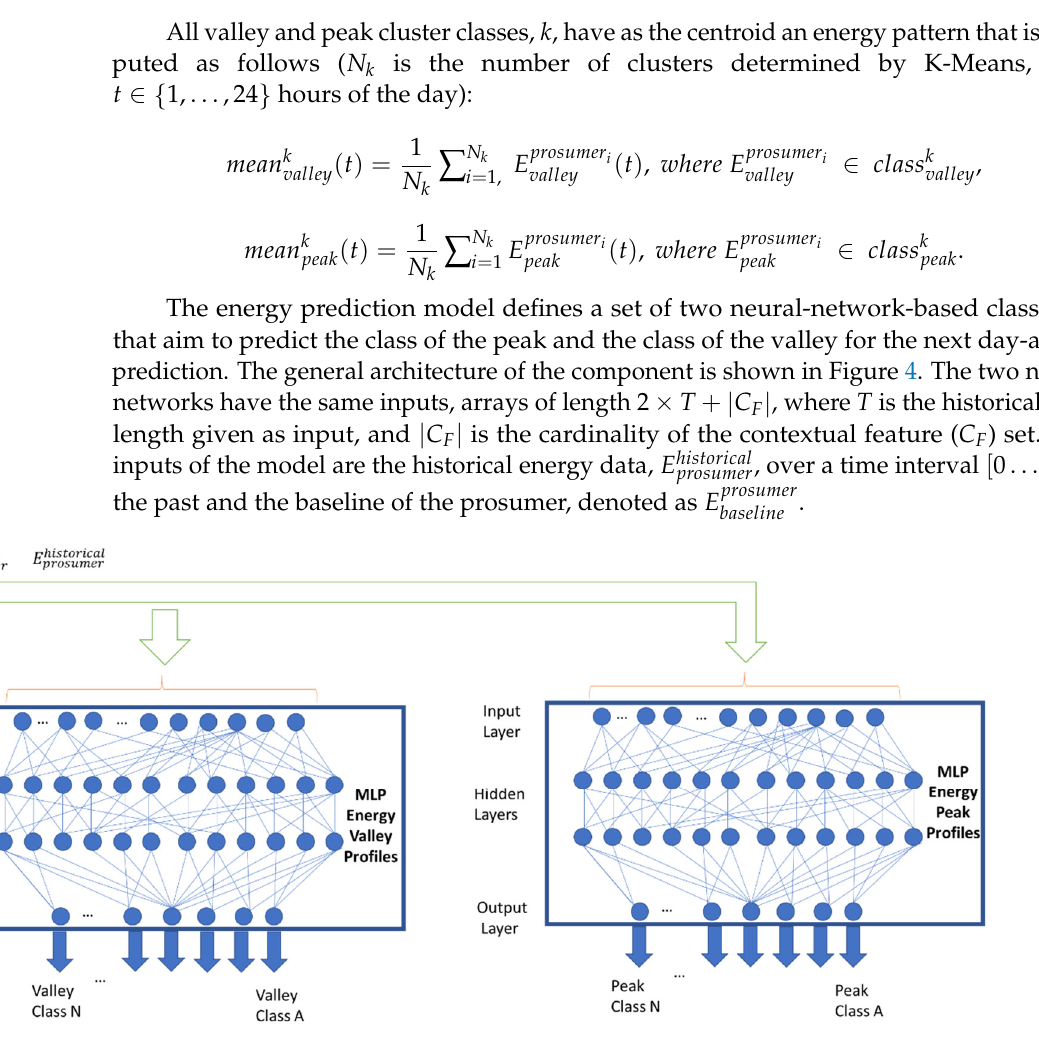
Figure 4. MLP-based neural network for energy prediction based on classification.